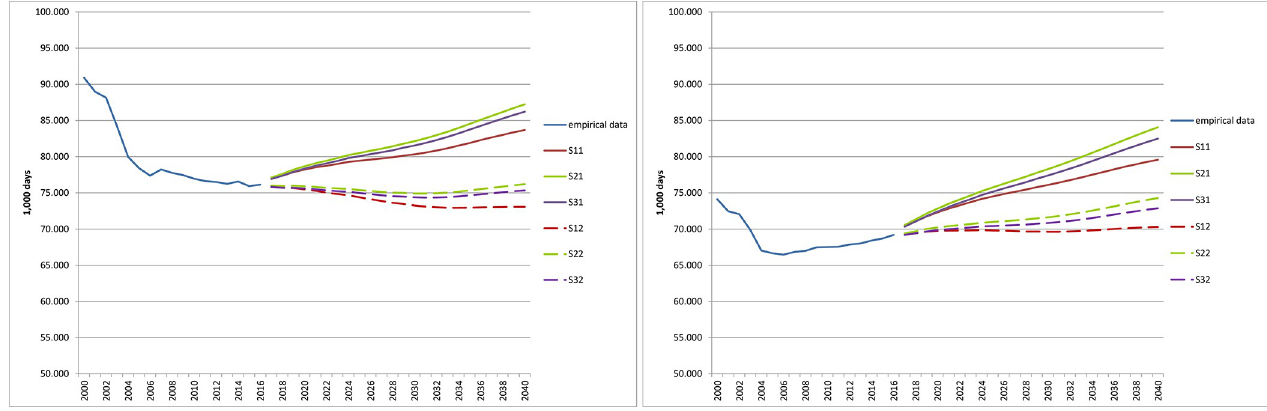
Table 6. Results of the projection of the scenarios: Treatment days in 1,000, women and men, 2015–2040. Scenario Women Men Both